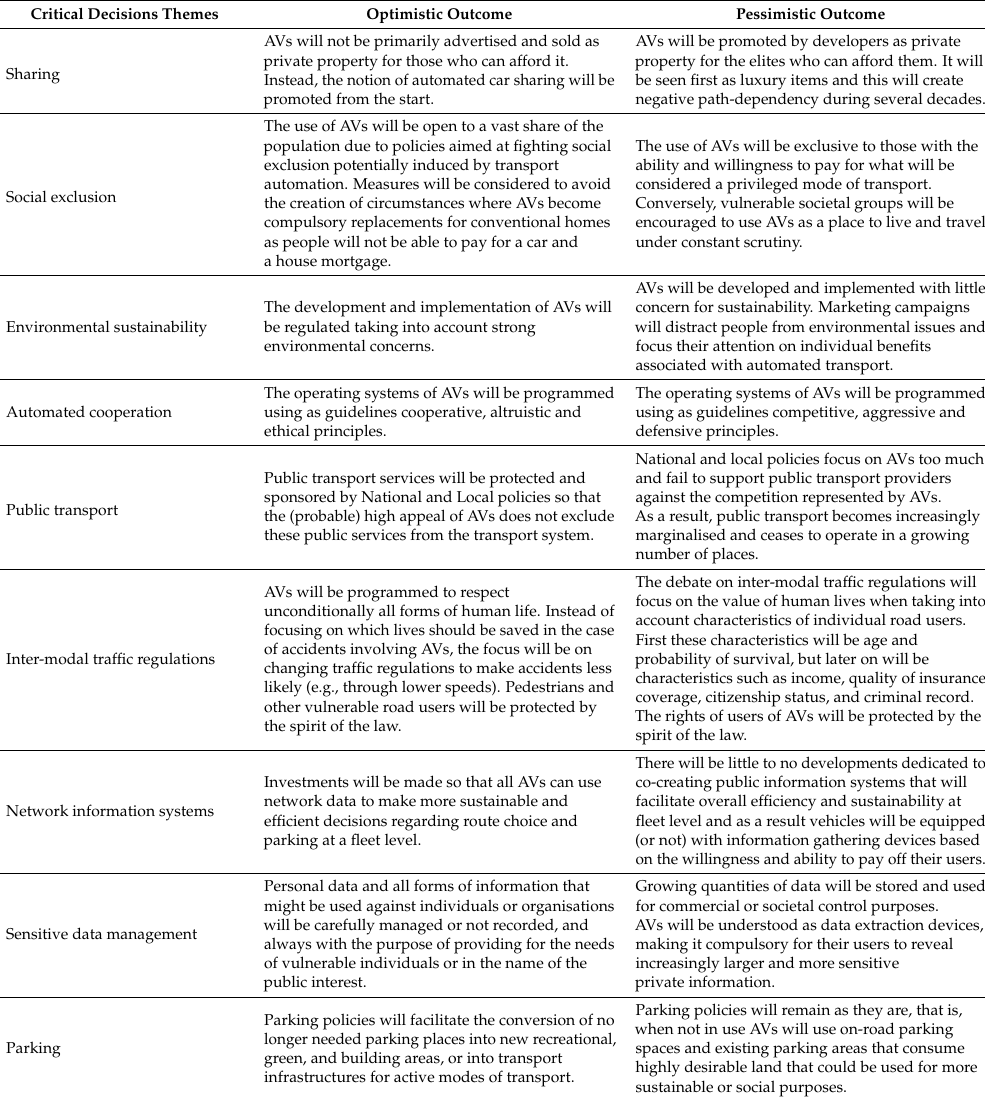
Table 1. Some key decisions concerning Automated